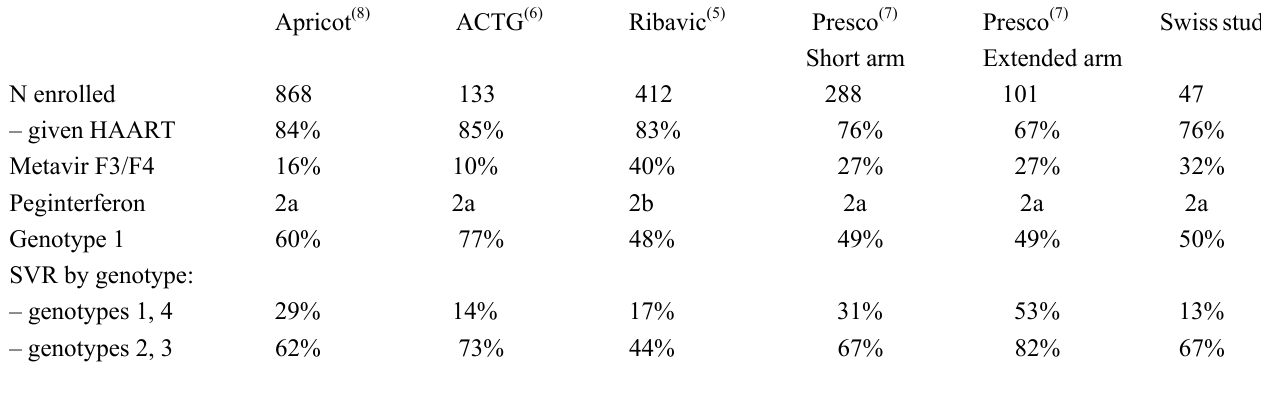
SVR in four pivotal studies on treatment of HCV in HIV-HCV co-infected patients; comparison with the Swiss